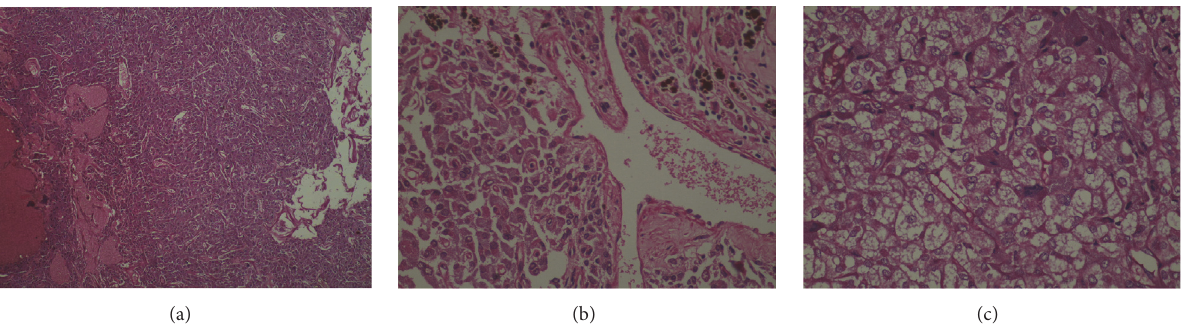
Figure 2: (a) Photomicrograph of broad ligament paraganglioma showing diffuse sheets of tumor cells having vesicular nuclei and moderate amount of eosinophilic granular cytoplasm were seen (H and E, × 100), (b) intracellular golden brown pigment (H and E, × 400), and (c) diffuse sheets of tumor cells having clear cytoplasm (H and E, ×